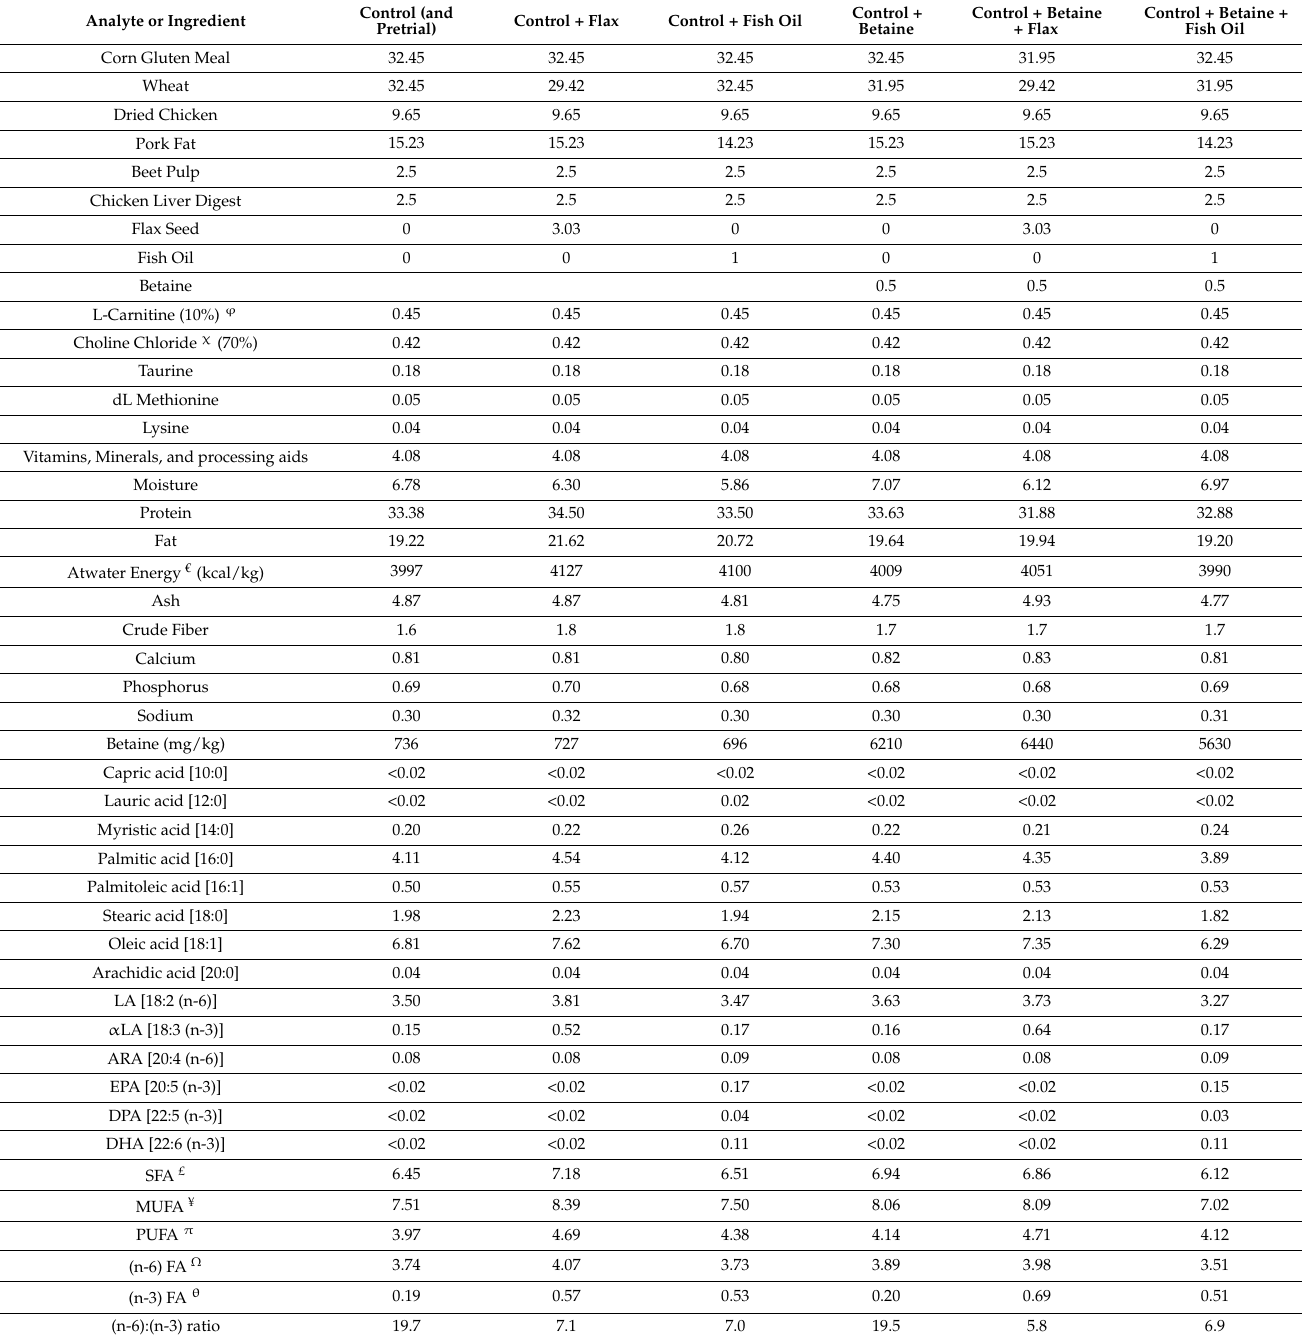
Table 1. Food composition and ingredient mix of pre-trial and test foods (grams/100 grams unless otherwise stated).